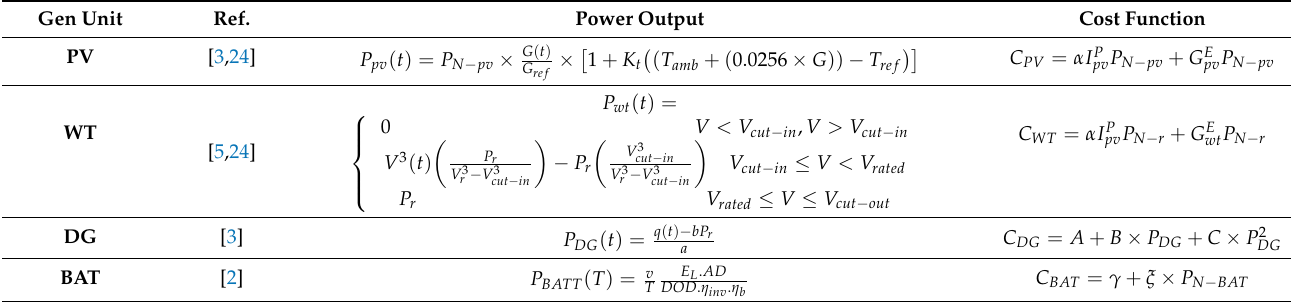
Table 1. Power output and cost function of power generation units in a HIMG.